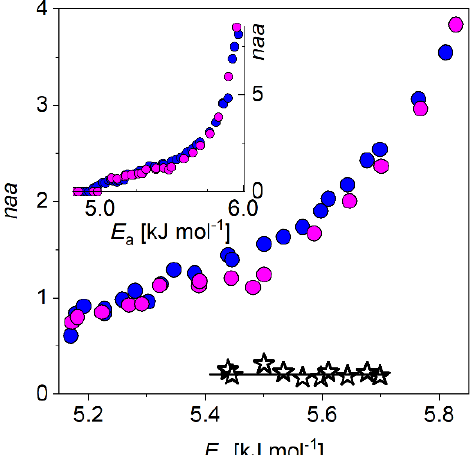
Figure 4. Sum of the measured melting diagrams of isolated thymosin-β 4 and stabilin-2 CTD (blue circles). Measured melting diagram of thymosin-β 4- -stabilin-2 CTD complex (magenta circles). Their difference is given by black stars and line. Inset: whole potential barrier range from the no mobile hydration water point to the melting point of water.